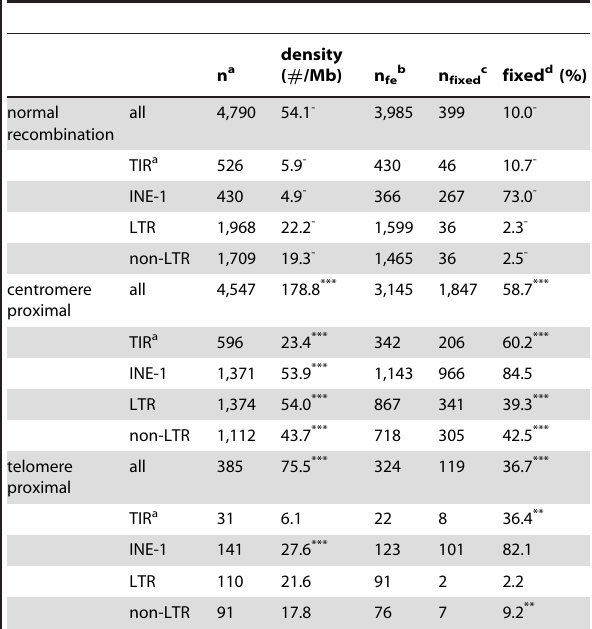
Table 3. Abundance of TE insertions in telomere proximal, centromere proximal, and normal recombining regions of D. melanogaster .